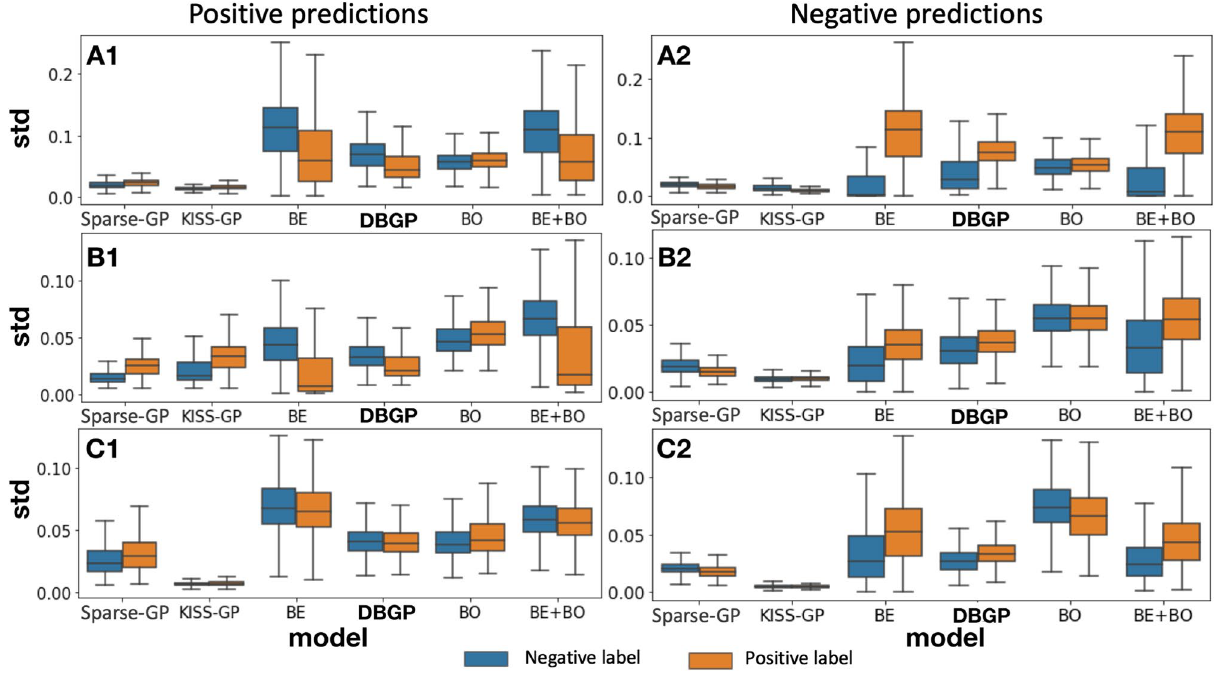
Figure 8. Distribution of std for positive and negative predictions. A, B and C represent the HF, diabetes and depression prediction tasks, respectively; 1 represents samples with positive prediction, and 2 represents samples with negative prediction, for instance: A1 means positive prediction for the HF prediction task. BDL-based methods as well as DBGP show the false positive and negative predictions have a higher uncertainty than true positive and negative predictions.